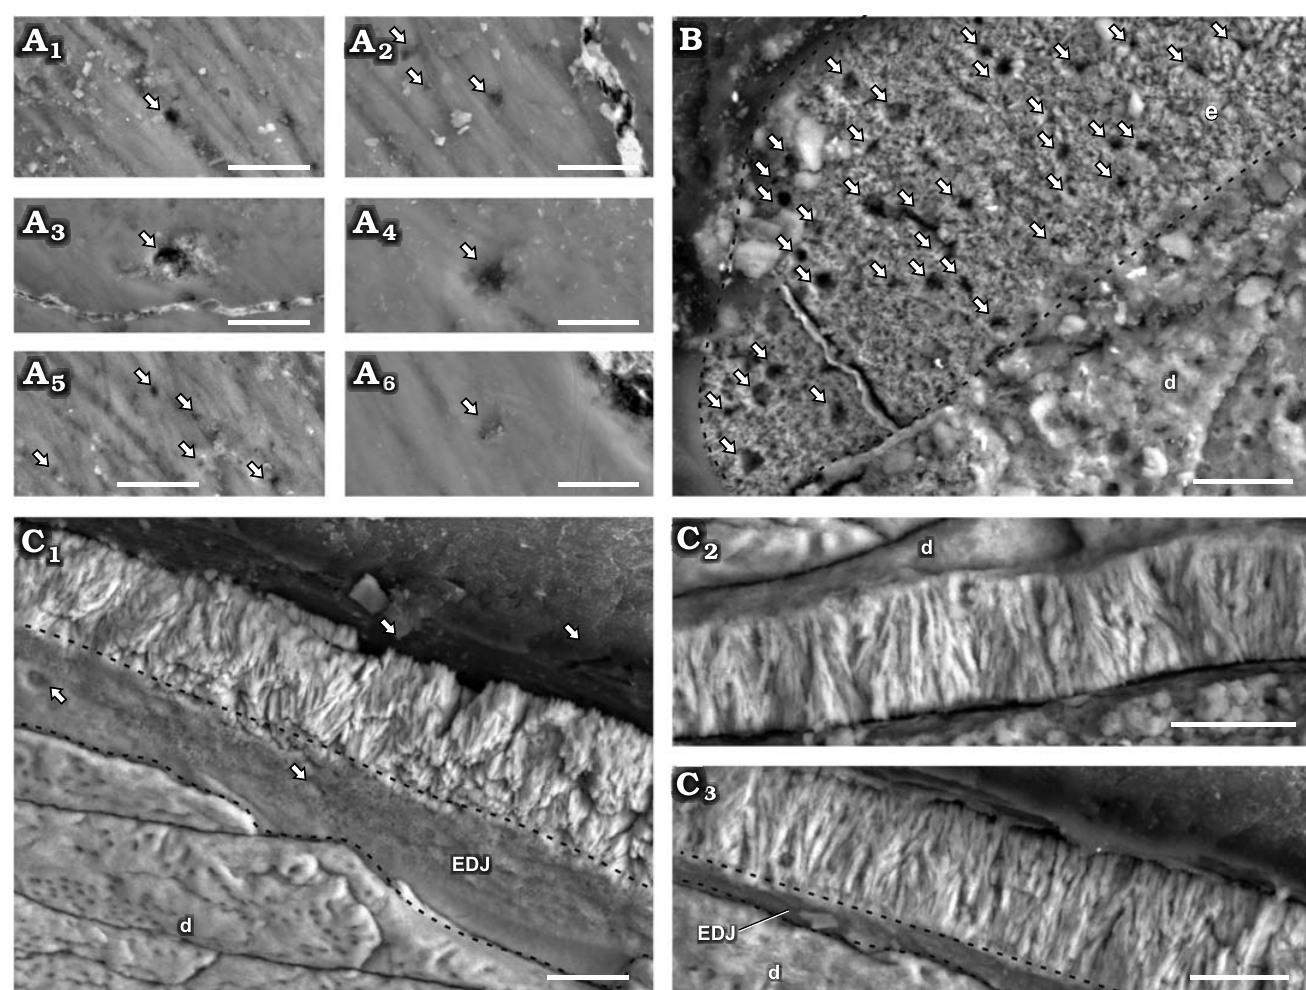
Fig. 2. Enamel in isolated maxillary teeth of a basal ornithischian Manidens condorensis Pol, Rauhut, and Becerra, 2011 from Cañadón Asfalto Formation (Queso Rallado locality, late Toarcian), Chubut province, Argentina. A . MPEF-PV 10861, details of different regions of the EES (A 1 –A 6 ); arrows point to tubules reaching the EES. B . MPEF-PV 10864, tangential section; arrows point to tubules transversally sectioned, dashed line indicates the limit of enamel. C . MPEF-PV 10823, longitudinal section detailing different regions of the enamel layer (C 1 –C 3 ); arrows point to tubules reaching the EDJ, dashed lines indicate the limits of the EDJ in oblique views. Abbreviations: d, dentine; EDJ, enamel-dentine junction; EES, external enamel surface. Scale bars 10 μ